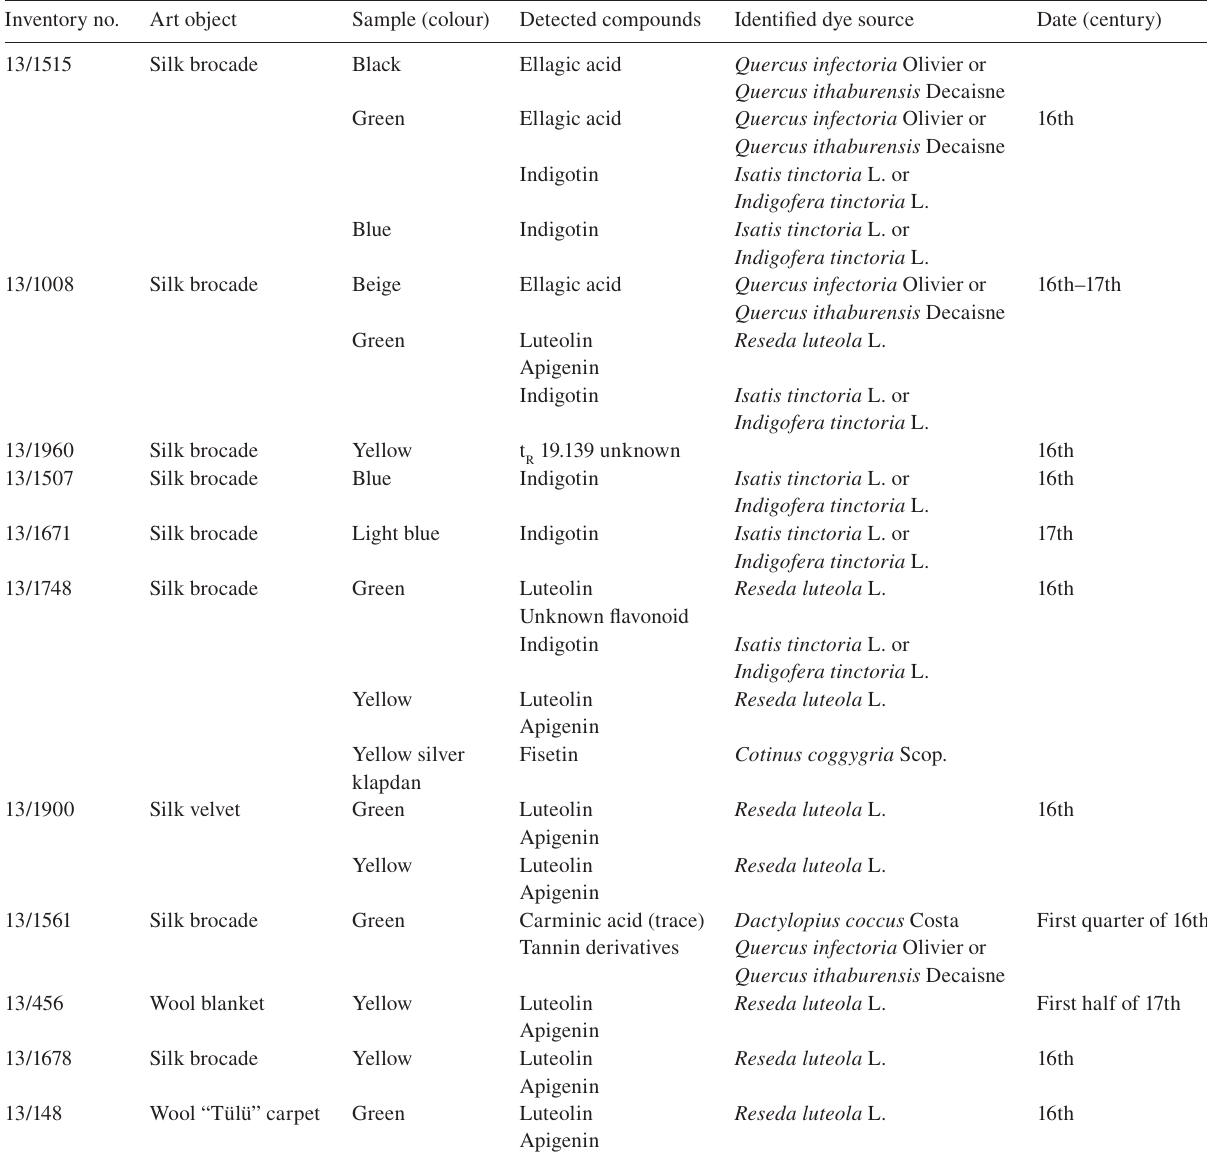
Table 2 Identifi ed colouring compounds by HPLC-DAD and dye source of the investigated textiles of the Ottoman period from the Topkapi Palace Museum.